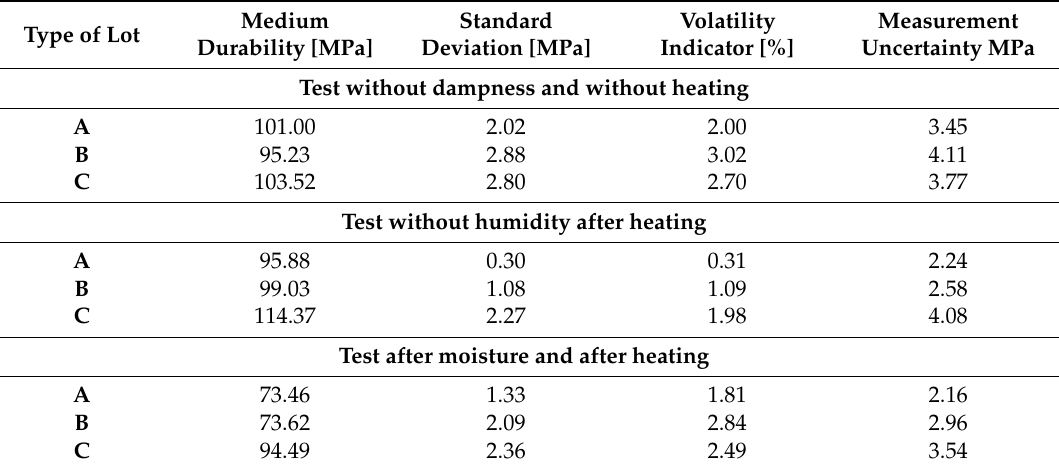
Table 3. Results of current research. Compressive strength.